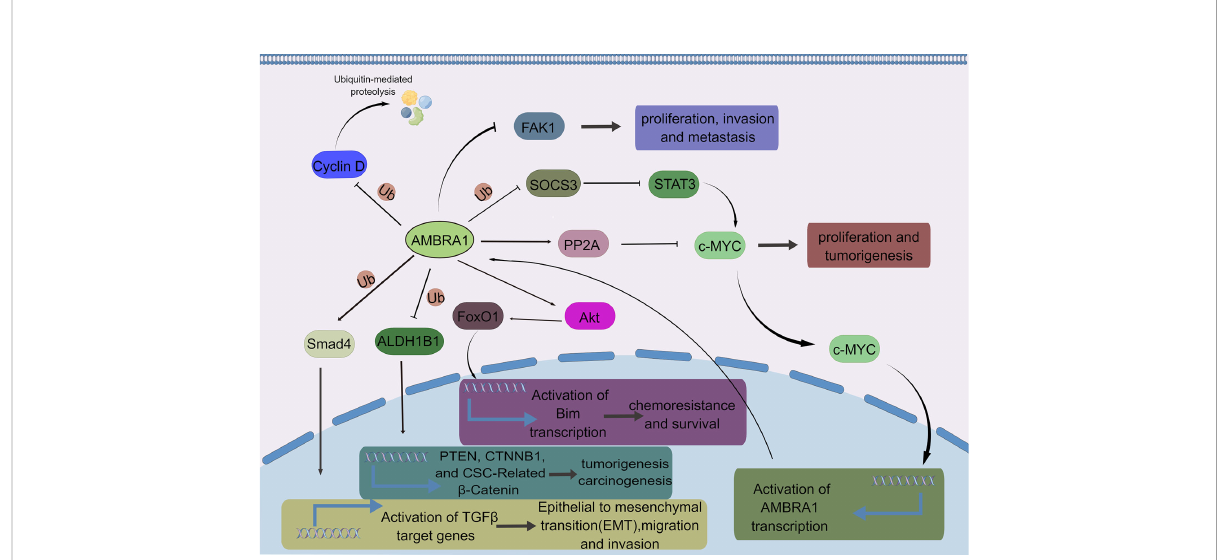
FIGURE 4 The major AMBRA1-related signaling pathways in cancer. AMBRA1 ubiquitinates cyclin D to promote its proteasomal degradation. AMBRA1 inhibits the proliferation, invasion, and metastasis of melanoma by inhibiting the phosphoactivation of FAK1. AMBRA1 inhibits the activity of c- MYC by enhancing the activity of PP2A, thereby inhibiting the proliferation and tumorigenesis of cancer cells, whereas AMBRA1 also promotes the activity of c-MYC through SOCS3/STAT3 pathway, enhancing tumor stem potential, growth, and migration of MBGroup3 stem cells. AMBRA1 promotes chemoresistance and survival in breast cancer cells through the AKT-FOXO1-BIM axis. AMBRA1 inhibits tumorigenesis and carcinogenesis by ubiquitylating ALDH1B1, a cancer stem cell marker. AMBRA1 mediates non-proteolytic polyubiquitylation of SMAD4 to enhance its transcriptional functions. Consequently, AMBRA1 potentiated TGF b signaling and critically promoted TGF b -induced epithelial-to- mesenchymal transition, migration, and invasion of breast cancer